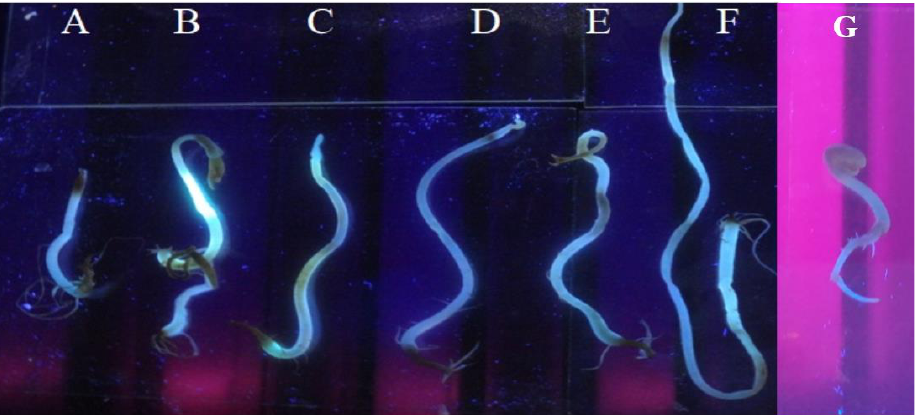
Figure 8. In-planta effect of CDs on V. radiata (L.) seeds; fluorescence in germinating seeds due to absorption of CDs; where ( A – G ) refer the treatments of CDs on germinating seeds at concentrations of 1, 2, 4, 8, 12, 16 mg/mL, and untreated (the control) seeds.